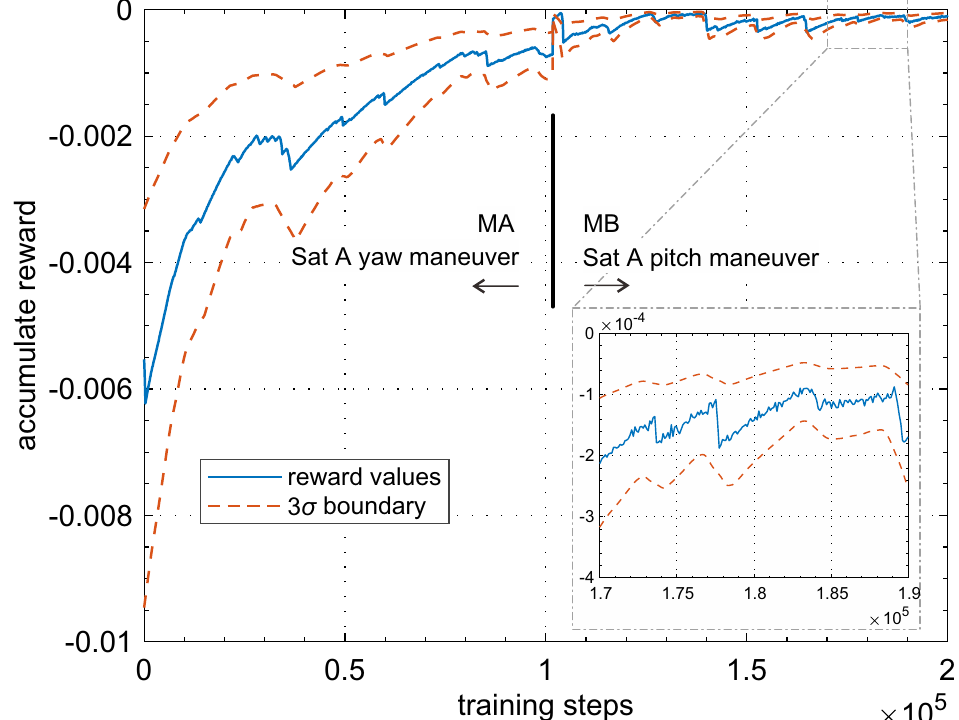
Figure 14. Learning data for laboratory HIL APC calibration